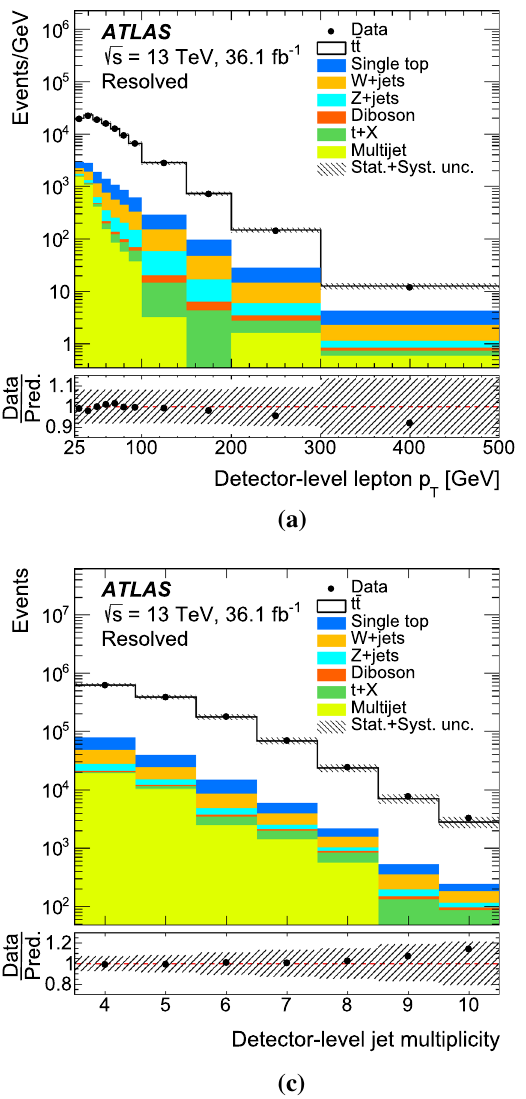
Fig. 1 Kinematic distributions in the (cid:3) + jets channel in the resolved area represents the combined statistical and systematic uncertainties (describedinSect.9)inthetotalprediction,excludingsystematicuncer- topology at detector-level: a lepton transverse momentum and b miss- taintiesrelatedtothemodellingofthe t ¯ t events.Underflowandoverflow ing transverse momentum E miss , c jet multiplicity and d transverse T events, if any, are included in the first and last bins. The lower panel momenta of selected jets. Data distributions are compared with pre- shows the ratio of the data to the total dictions using Powheg + Pythia8 as the t ¯ t signal model. The hatched